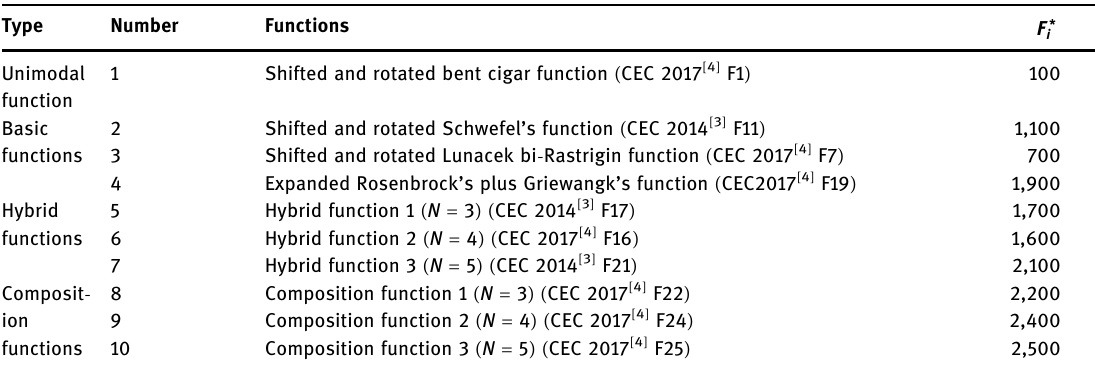
Table 2: Summary of the CEC2020 test suite